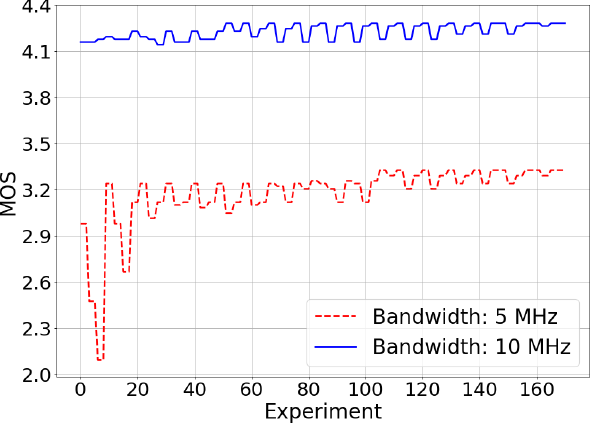
Figure 5. Simulated scenario—MOS